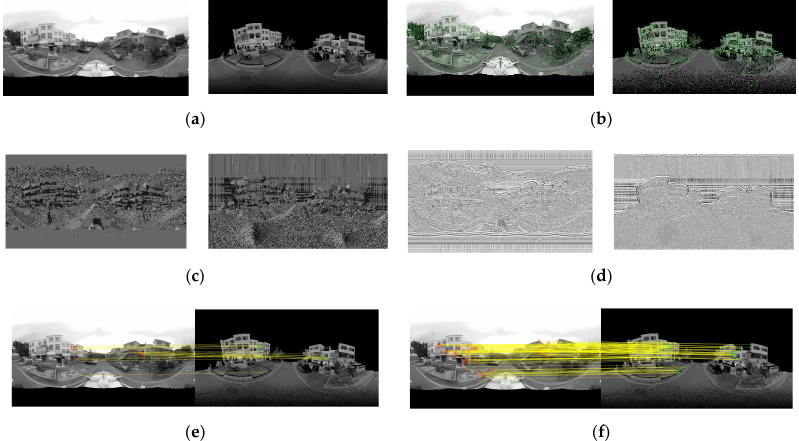
Figure 3. Comparison of our method and the RIFT: ( a ) input image pair; ( b ) feature detection results; ( c ) MIMs; ( d ) MIM-OPCIMs; ( e ) matching based on MIM; ( f ) matching based on MIM-OPCIM. MIM is constructed via the log-Gabor convolution sequence. The convolution se- quence was obtained in the PC map calculation stage, so the computational complexity of MIM is very small and does not entail too many additional calculations. The specific con- struction method of MIM is shown in Figure 4. Given an image 𝐼(𝑥,𝑦) , 𝑀 (cid:3041)(cid:3042)(cid:3032) and 𝑀 (cid:3041)(cid:3042)(cid:3042) rep- resent the even-symmetric and odd-symmetric log-Gabor wavelets at scale 𝑛 and orien- tation 𝑜 . The two wavelet functions are convolved with the image signal to obtain the response components 𝑒 (cid:3041)(cid:3042) (𝑥,𝑦) and 𝑜 (cid:3041)(cid:3042) (𝑥,𝑦) . For the obtained response component 𝑒 (cid:3041)(cid:3042) (𝑥,𝑦) and 𝑜 (cid:3041)(cid:3042) (𝑥,𝑦) , we first calculate the wavelet transform amplitude 𝐴 (cid:3041)(cid:3042) (𝑥,𝑦) at scale 𝑛 and orientation 𝑜 ; then, for orientation 𝑜 , all magnitudes of the scale 𝑆 are summed to obtain the log-Gabor convolutional layer 𝐴 (cid:3042) (𝑥,𝑦) . [𝑒 (cid:3041)(cid:3042) (𝑥,𝑦),𝑜 (cid:3041)(cid:3042) (𝑥,𝑦)] = [𝐼(𝑥,𝑦) ∗ 𝑀 (cid:3041)(cid:3042)(cid:3032) ,𝐼(𝑥,𝑦) ∗ 𝑀 (cid:3041)(cid:3042)(cid:3042) ]